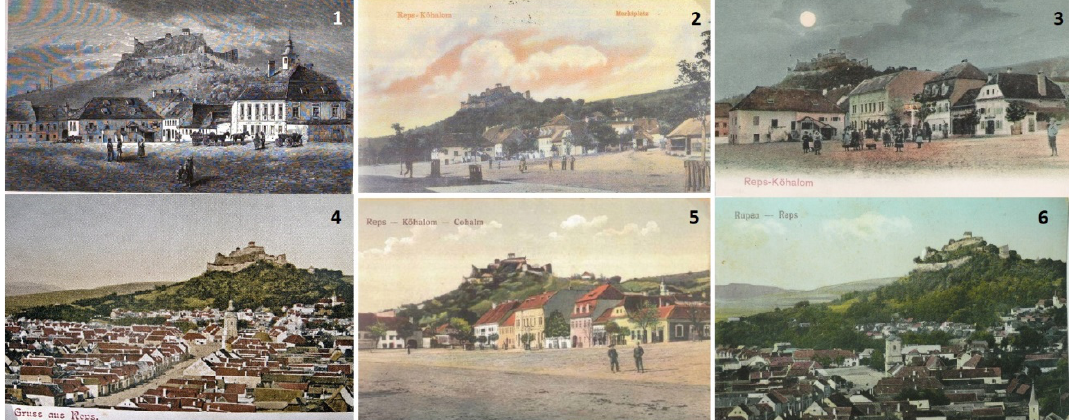
Figure 2: Postcards illustrating the town of Rupea from the same angle and in chronological order, 1 – Lithograph on Reps by G. Pearson 1851 (Boner, 1865, p. 244), 2 – Postcard on Reps- Kőhalom approx. 1900, 3 – Postcard commemorating the first public gas lighting in Reps- Kőhalom approx. 1910, 4 – Postcard with greetings “Gruss aus Reps” before the First World War, 5 and 6 Postcards on Reps- Kőhalom-Cohalm-Rupea from the interwar period. The Personal Collection of Zoltan